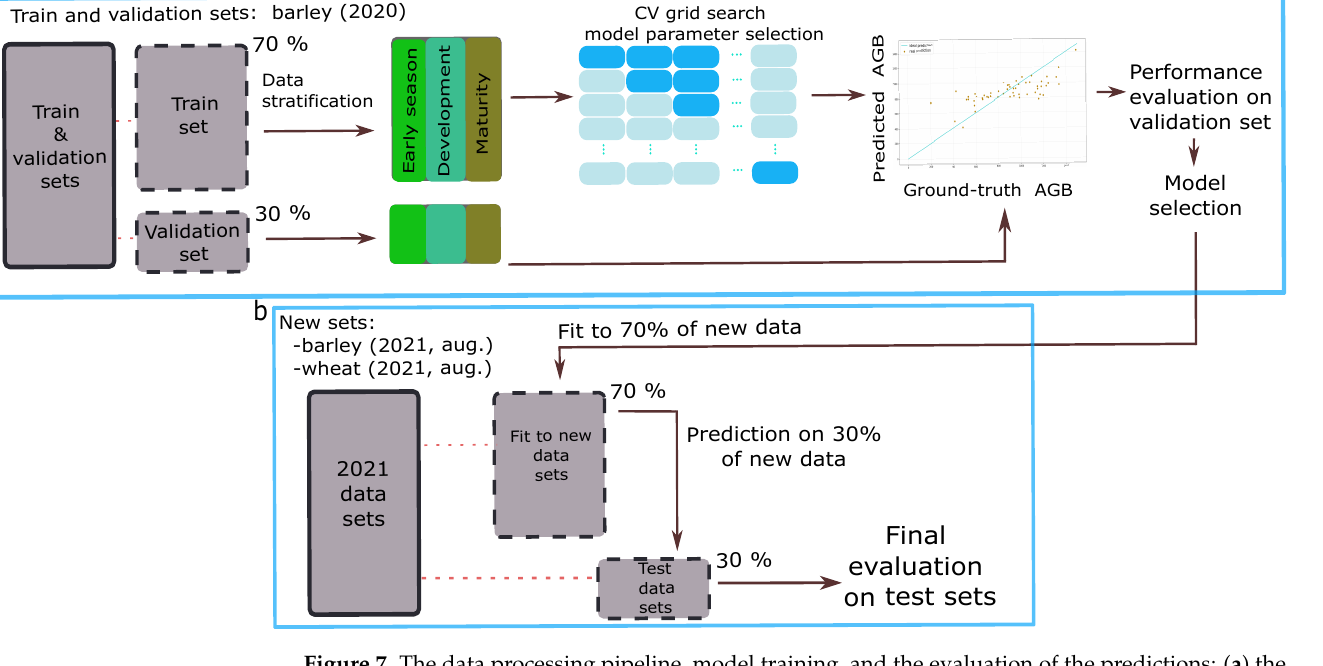
Figure 7. The data processing pipeline, model training, and the evaluation of the predictions: ( a ) the 2020 barley dataset was split into training and validation sets. The instances in both sets were stratified according to the mean AGB values from the training distribution. A cross-validated grid search was conducted to optimize the hyperparameters for model selection; ( b ) the ML model with the best performance was fitted to a new dataset (i.e., 70% of either the 2021 barley or wheat datasets) and the final prediction performance was evaluated using the remaining test set (i.e., 30% of the 2021